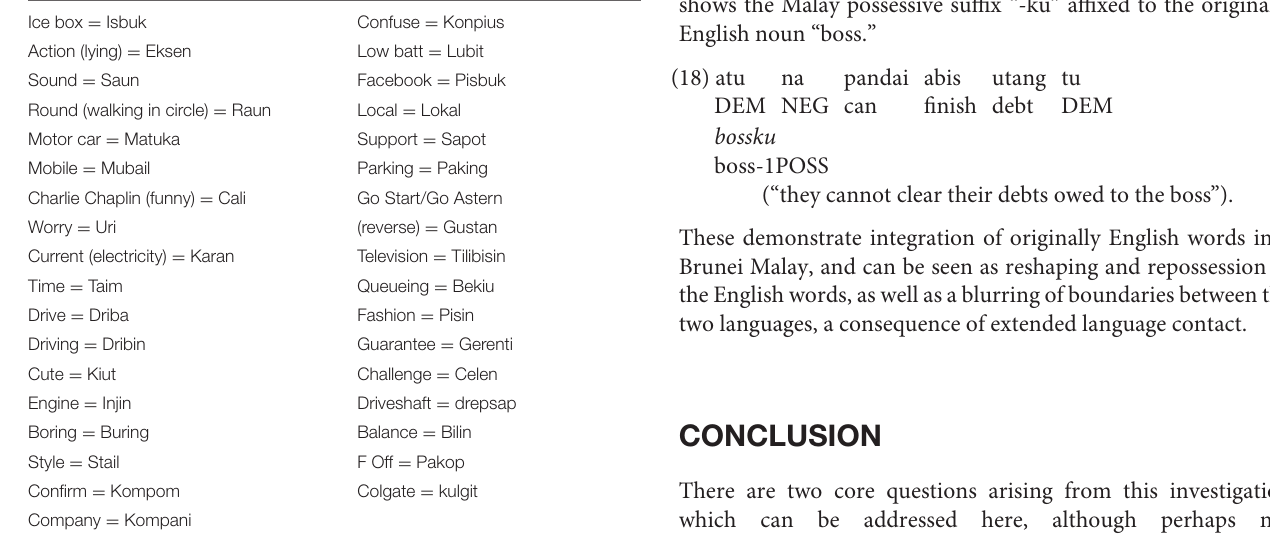
TABLE 4 | Pronunciation spellings and other translingual